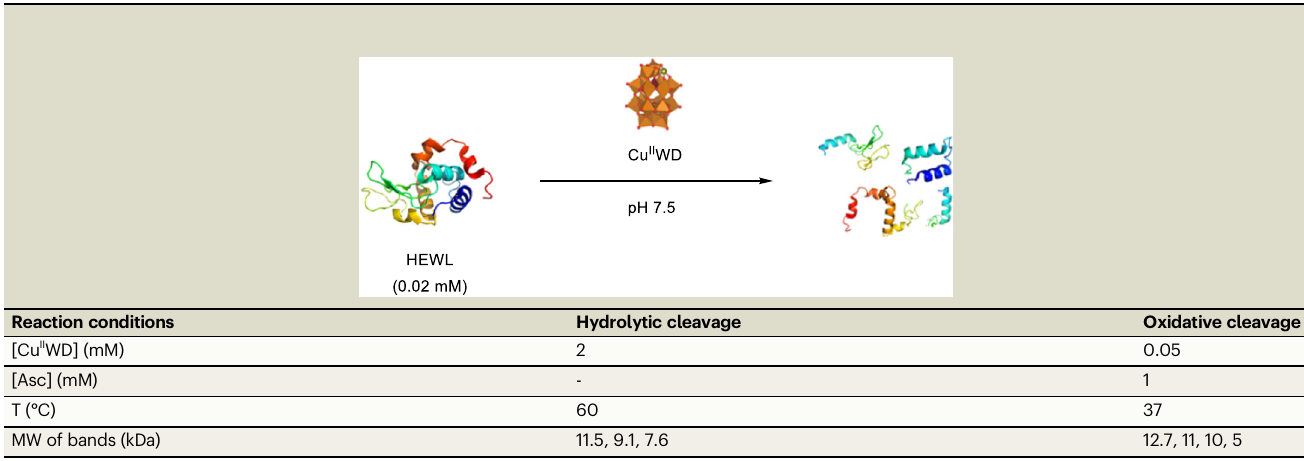
Reaction conditions